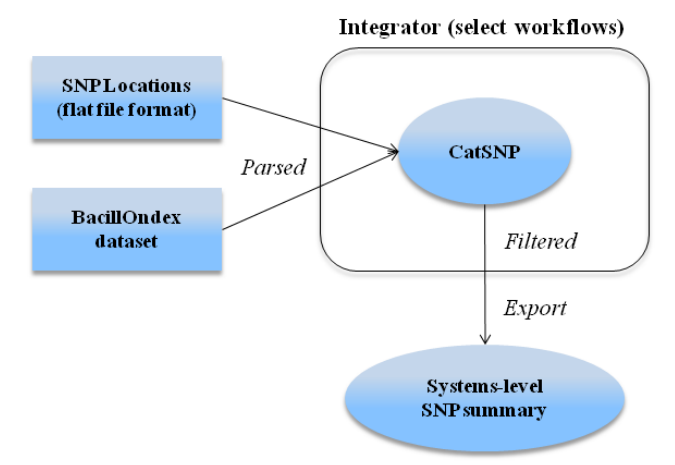
Figure 1. Visualisation of the CatSNP workflow within the Integrator of the Ondex